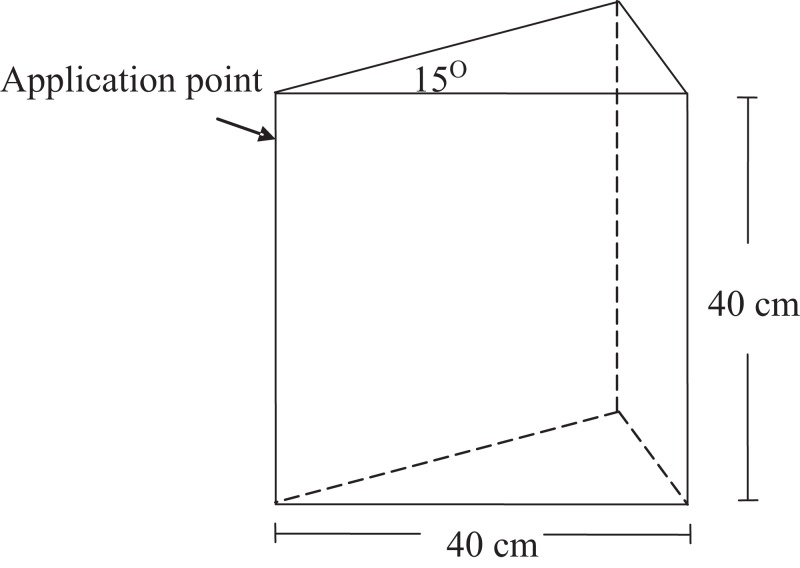
Geometry of the wedge apparatus.